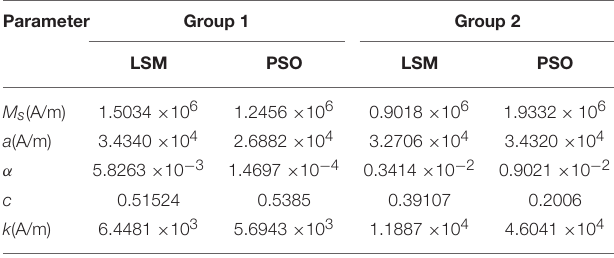
TABLE 1 | Parameters optimization of J-A model for MR fluid